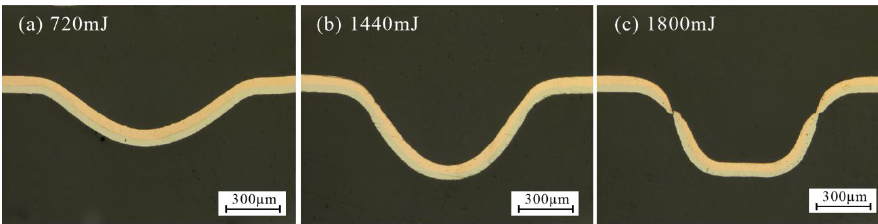
Figure 5. Three profiles of different forming depths at 25 °C and different laser energies: ( a ) 720 mJ, ( b ) 1440 mJ and ( c ) 1800 mJ.